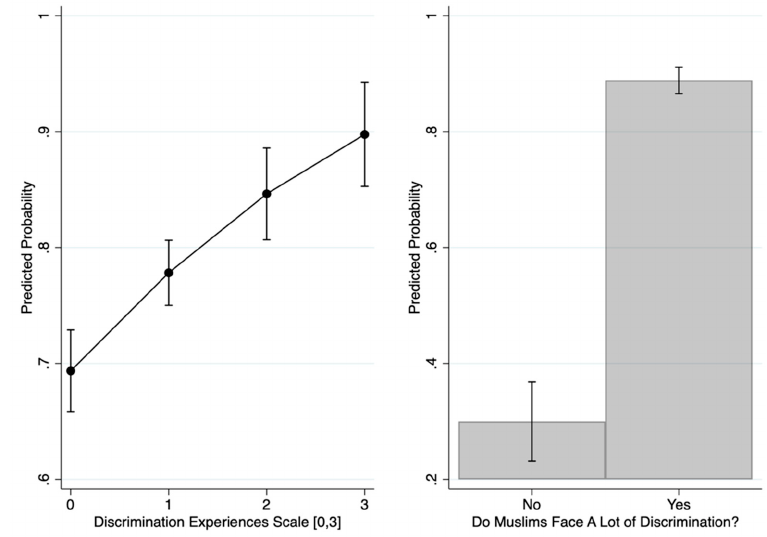
Figure 2. Predicted probability of perceiving discrimination against Black people, computed from models 3 (left) and 4 (right) of Table 2, which utilize the 2017 data and include controls for age, gender, ethnicity, generation, income, mosque attendance, frequency of prayer, and political ideology.